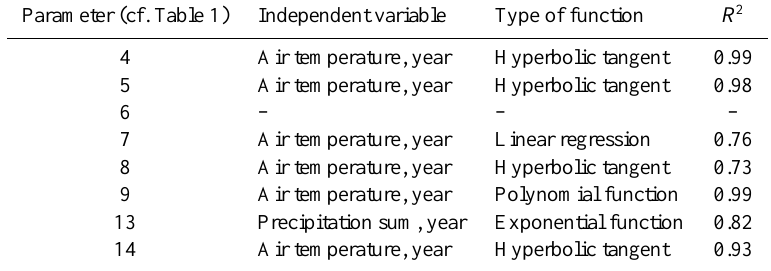
Table 2. Types of curve fitting of derived climate indices to primary parameters as basis for interpolation ( R 2 – coe ffi cient of determination). Parameter (cf. Table 1) Independent variable Type of